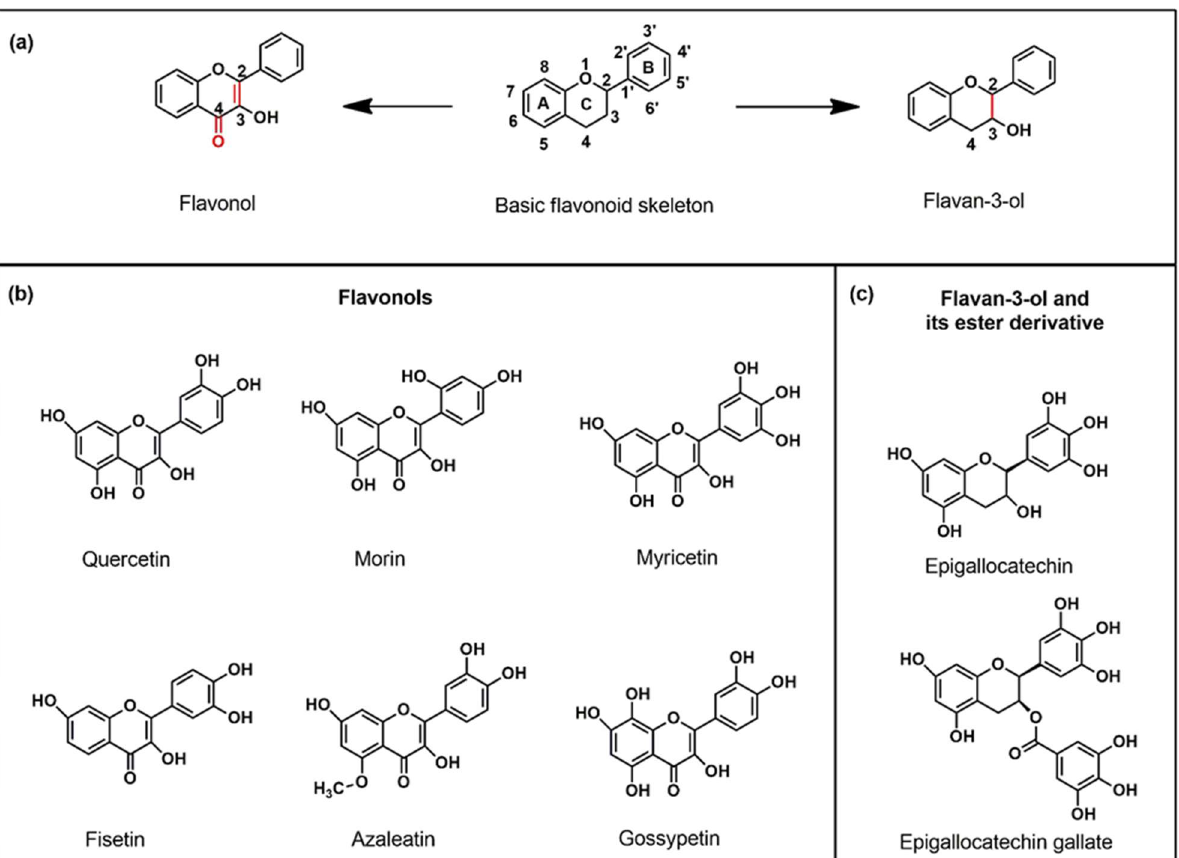
Figure 1. ( a ) Representative structure of basic flavonoid skeleton (phenylbenzopyran) along with its two subclasses used in this study—flavonol and flavanol demonstrating the differences at C4 position and the bond between C2 and C3. ( b ) Chemical structures of six flavonols (quercetin, morin, myricetin, fisetin, azaleatin, gossypetin) and ( c ) flavan-3-ol (epigallocatechin) and its ester derivative (epigallogatechin gallate) used in this study.